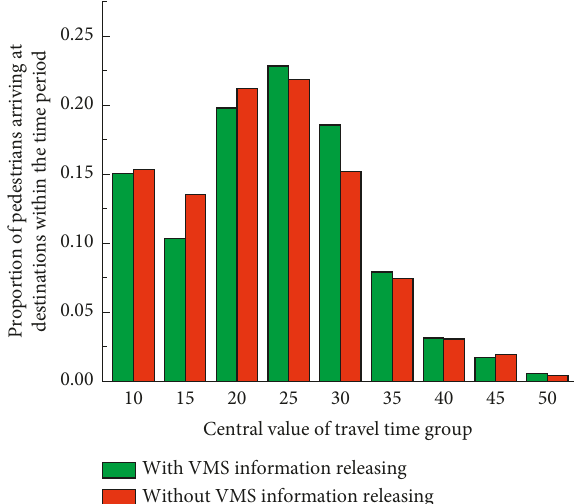
Figure 17: Travel time distribution of pedestrians for the scenario of ingress.